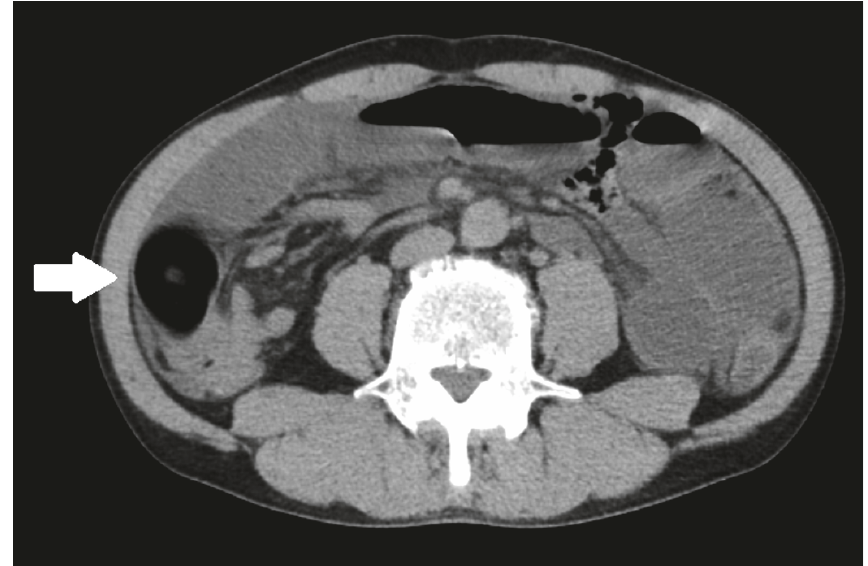
Figure 3: Computed tomography revealed intestinal obstruction by a 3 × 4 cm foreign body (white arrow) within the right lower abdominal cavity.